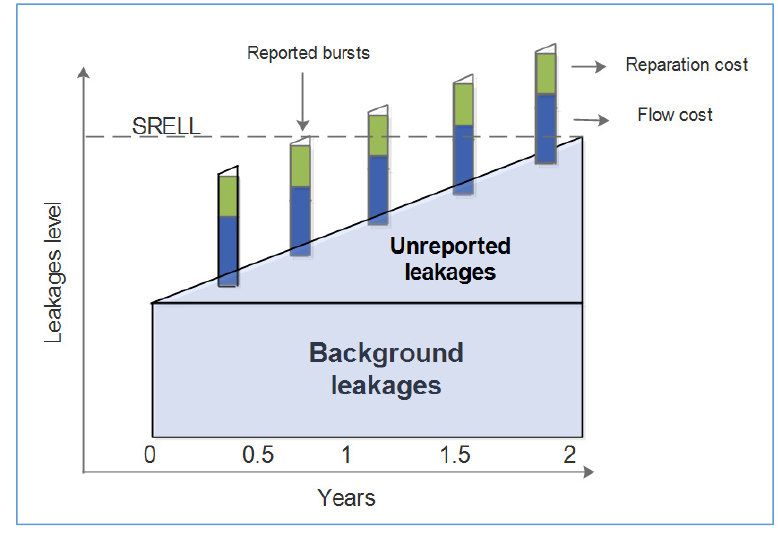
Figure 8. Real losses structure according to the BABE concept (modified from [23]).